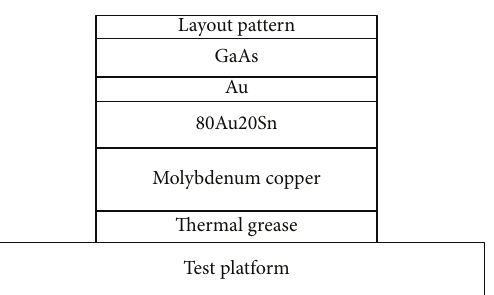
Figure 7: The schematic drawing of each layer for the simulation